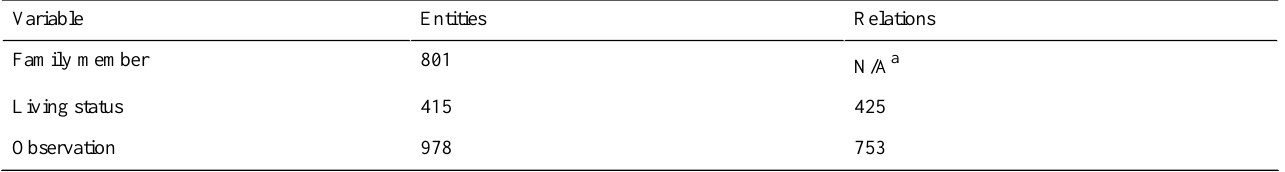
Table 1. Number of annotated entities and relations in the training